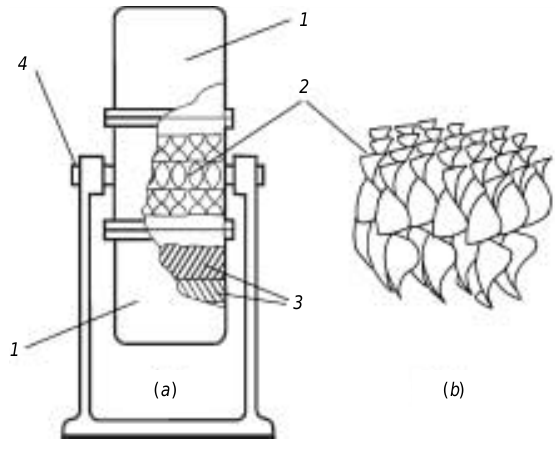
Schematic diagram of the alternating revolving bulk solids mixer ( a ) outline of the mixer, 1 - containers, 2 - grids composed of motionless mixer elements, 3 - components to be mixed, 4 - mount with rotating shaft, ( b ) helical motionless mixers arranged in